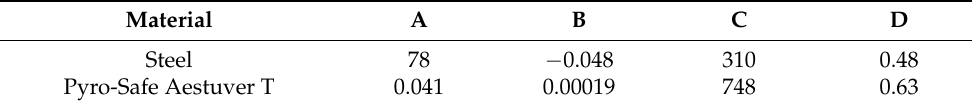
Table 4. Coefficients of thermal conductivity and heat capacity of the materials.